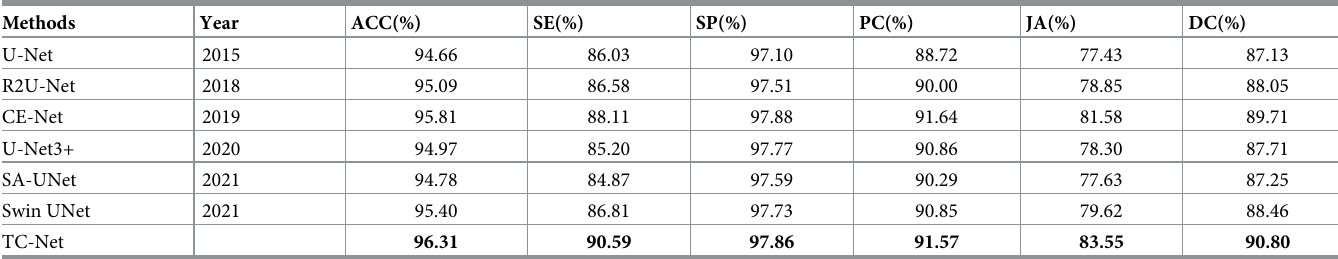
Table 4. Comparative experiments based on ISIC2018 dataset.